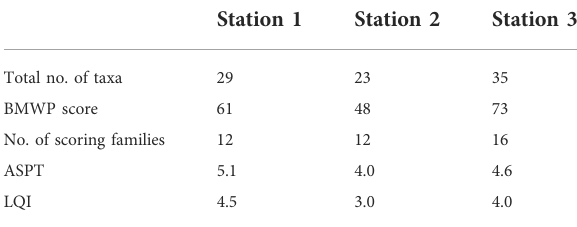
TABLE 4 BMWP, ASPT, and LQI scores across the